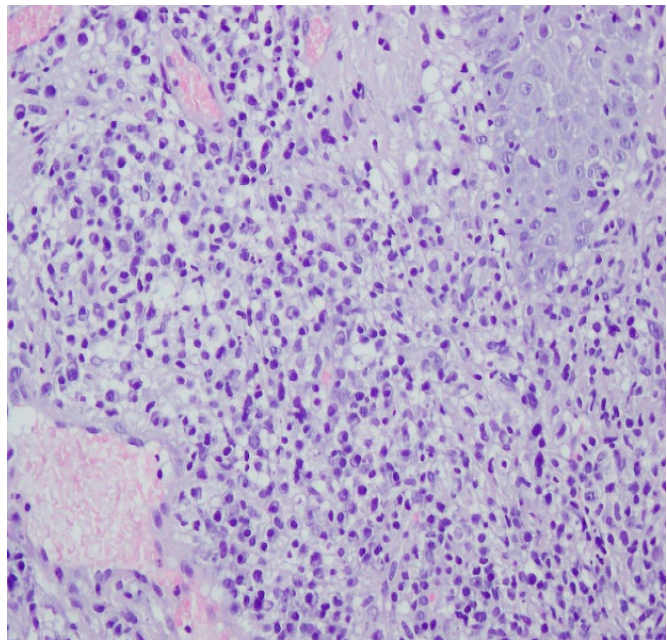
Figure 10. Thickened epidermis. Lymphocytic and histiocytic inflammatory infiltration with multiple plasmacytes. Histopathological picture and data from the history are consistent with syphilis.